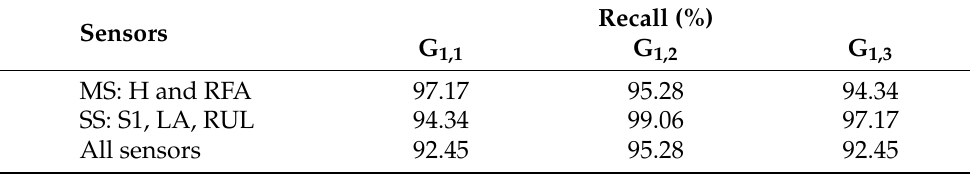
Table 6. Recall achieved for G 1 using